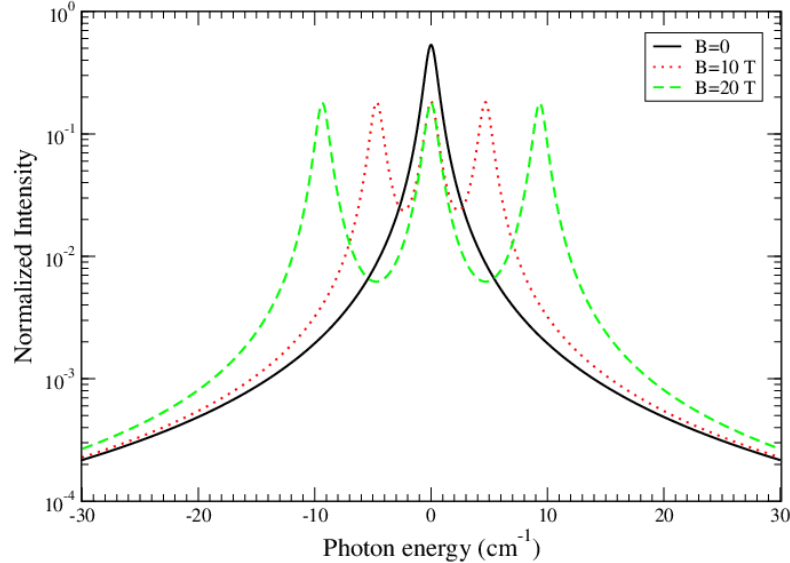
Figure 4. Hydrogen Lyman-10 line shapes at N e = 10 13 cm − 3 and T e = 1 eV for different values of the static magnetic field: B = 0, 10 and 20 T. The photon energy is relative to the center-of-gravity of the profile. The Doppler effect is omitted in the